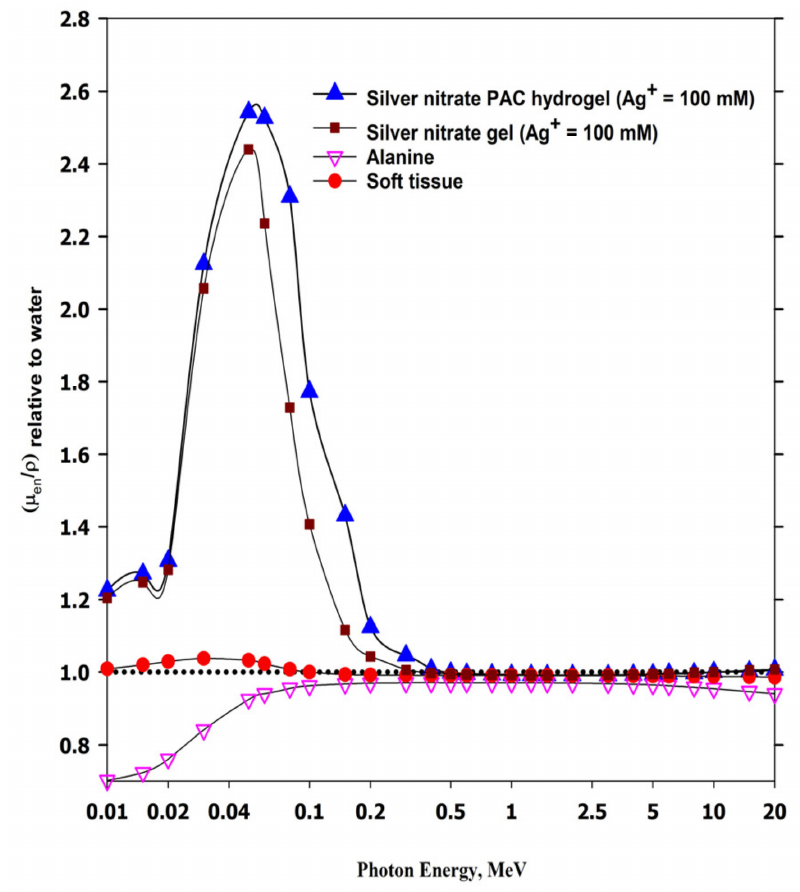
Figure 11. The mass energy-absorption coefficients of silver nitrate PAC hydrogel dosimeter (100 mM Ag + ions) and silver nitrate gel dosimeter (100 mM Ag + ions) relative to ( µ en / ρ ) W of water against photon energy in the range of 0.1–20 MeV and compared with alanine dosimeter and soft tissue. Table 5. Uncertainty budget of PAC hydrogel dosimeter in the dose range up to 100